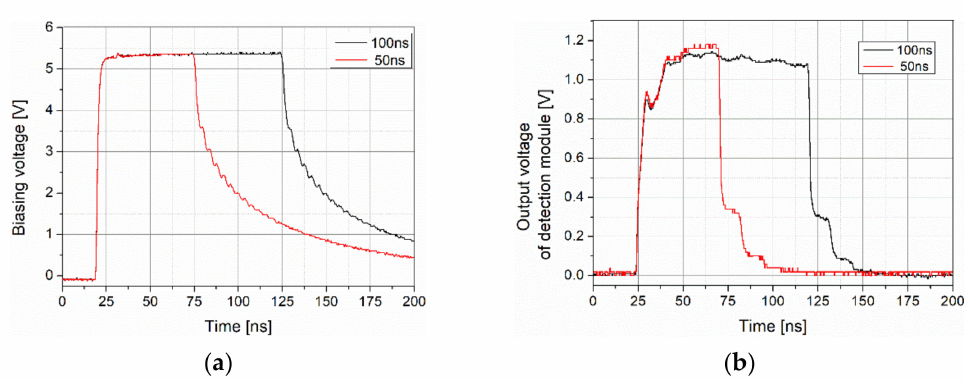
Figure 6. Registered signals for different pulse durations: biasing voltage ( a ) and radiation pulses ( b ). Some virtues of the experimental and simulation results are shared, e.g., inflection